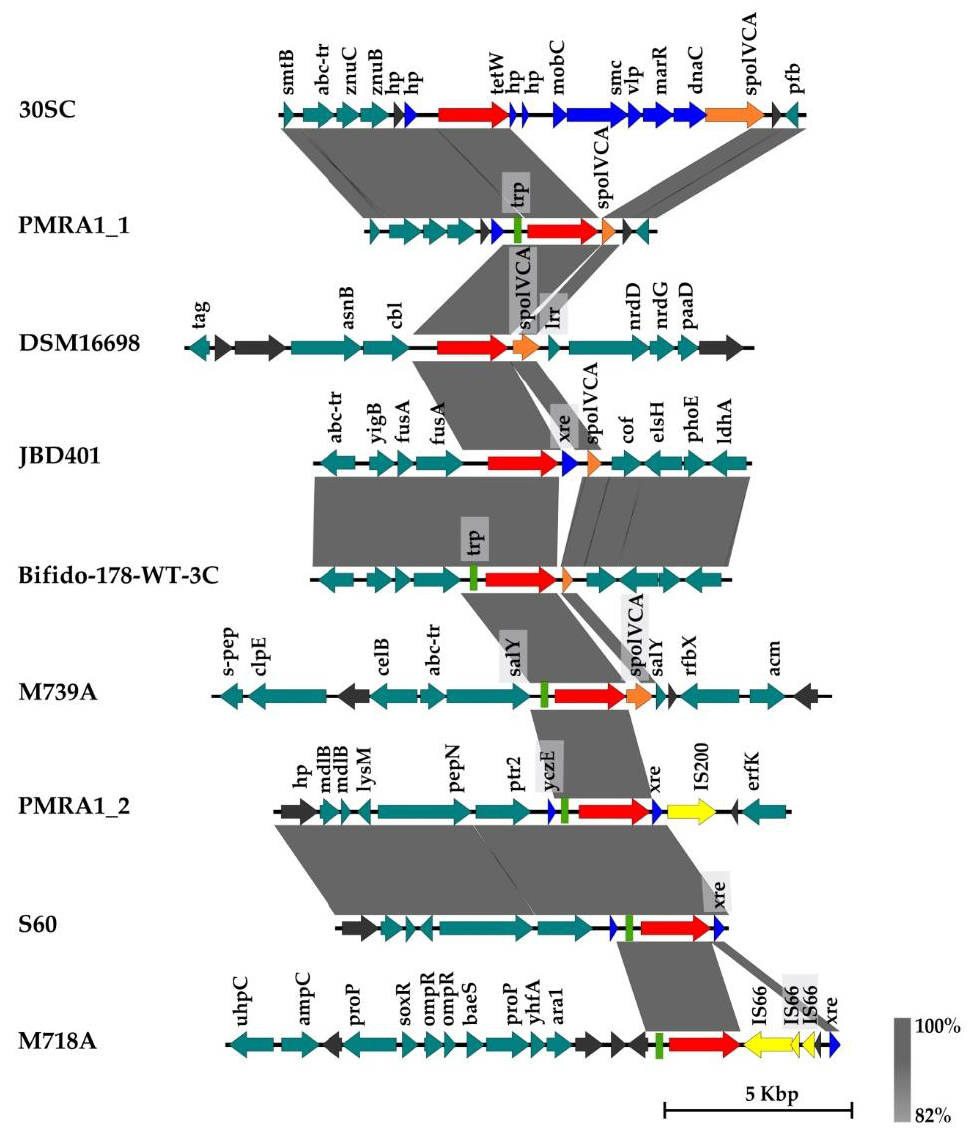
Figure 3. Organization of CDS in the contigs harboring tetW and site-specific recombinase spoIVCA or tetW and xre (DNA-binding transcriptional regulator) in L. amylovorus strains. Yellow arrow — CDS associated with mobility (e.g., IS — transposase), red arrow — tetW gene, teal arrow — CDS with functional annotation, gray arrow — hypothetical protein, orange — SpoIVCA site-specific recombinase, green rectangle — tetW regulatory protein ( trp ), blue arrow — CDS identified in other bacterial spp. (e.g., Treponema succinifaciens DSM 2489 or Victivallales bacterium CCUG 44730). The gray zones between sequences represent blastn sequence identity (generated by EasyFig).